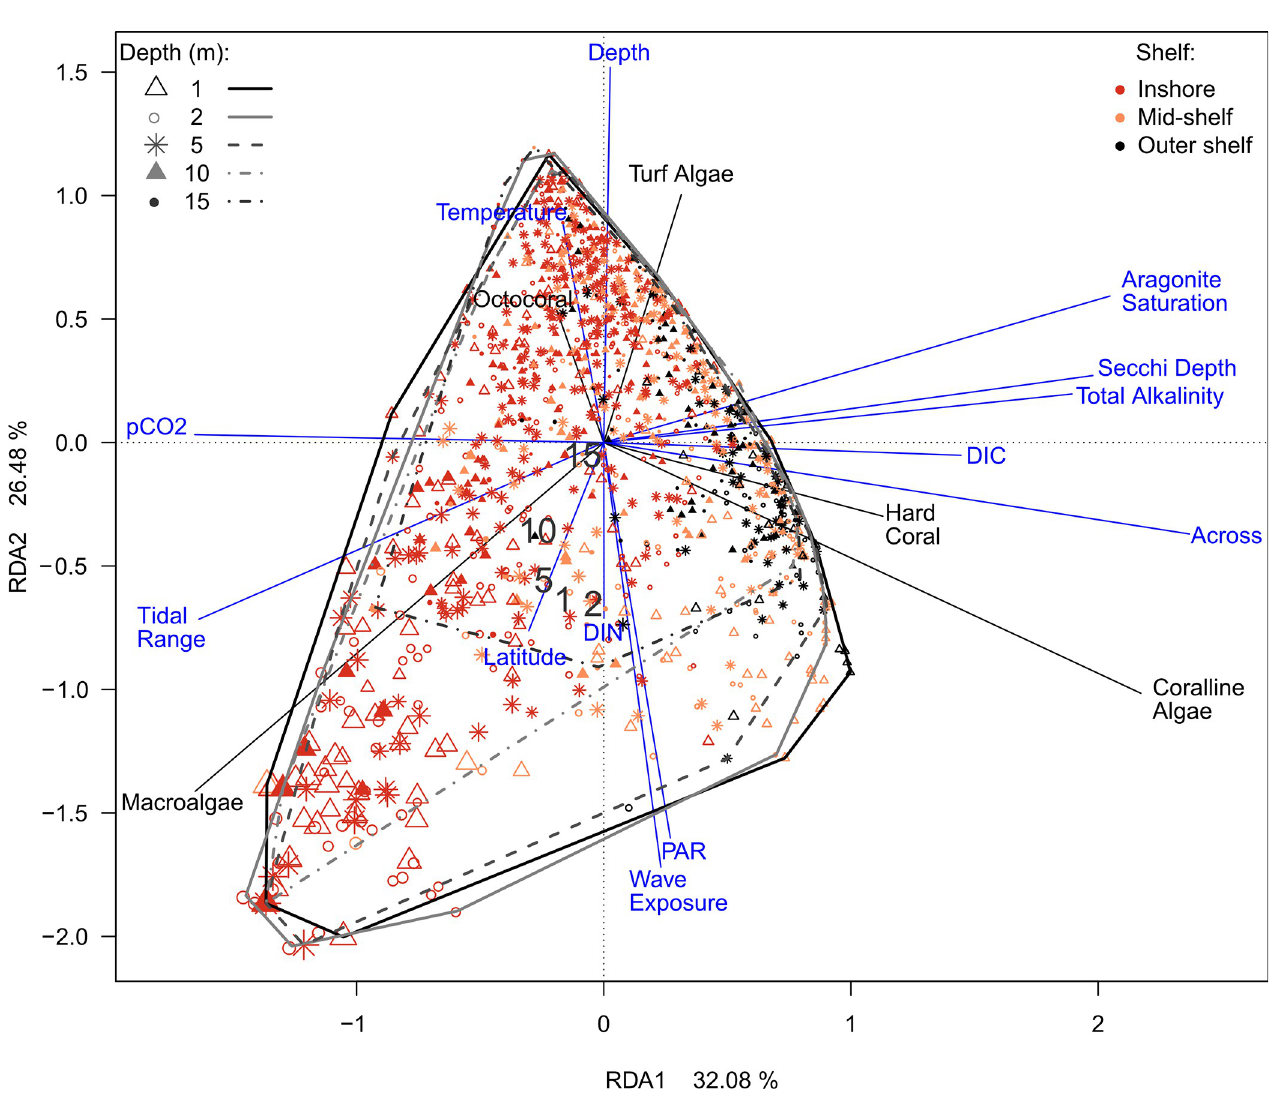
Fig 6. Redundancy analysis, showing the relationships between benthos and predictors. Plot based on the one-off surveys, and the main benthic groups (black arrows: cover of total macroalgae, hard corals, soft corals, coralline algae and turf algae, and their spatial and environmental predictors (blue arrows; definitions in S1 Table in S1 File). Species and environmental data scaled by eigenvalues (significance of relationships: Table 1). Each symbol represents a site, colors indicate shelf position, size increases with MA (range: 0% - 100% cover), and the symbols and hulls denote survey depths.